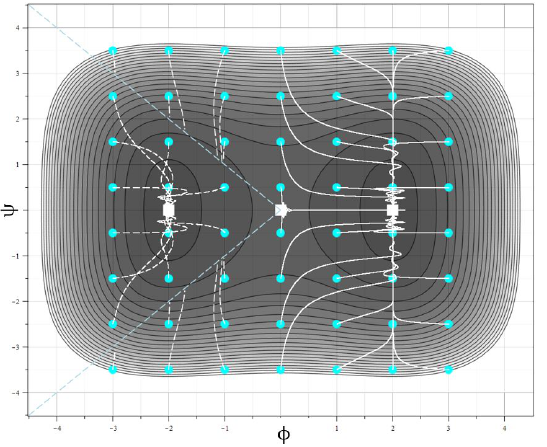
Figure 10. Phase portrait of the model (50) and (51).